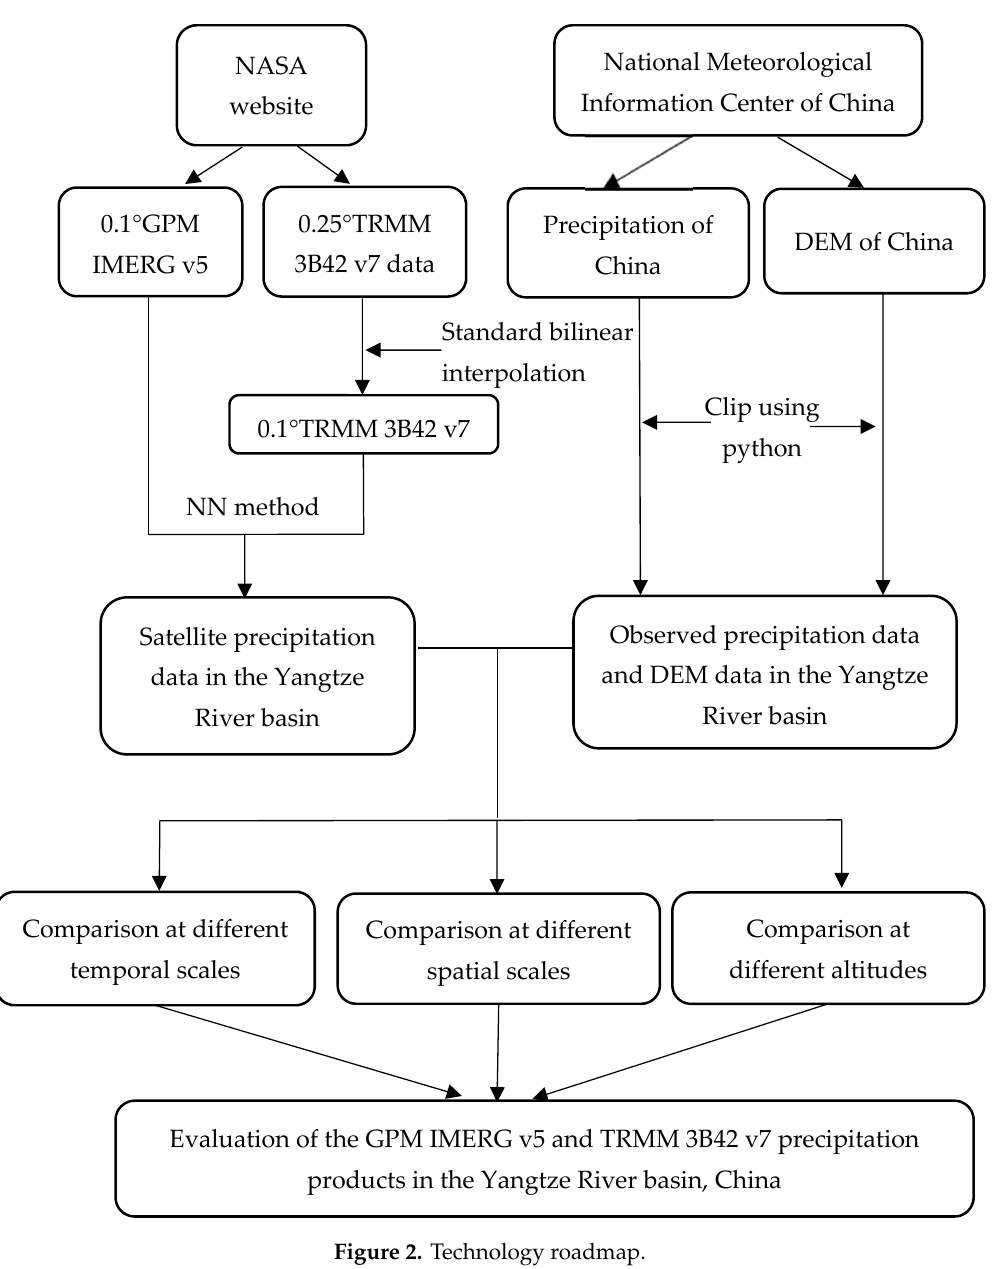
Figure 2. Technology roadmap.